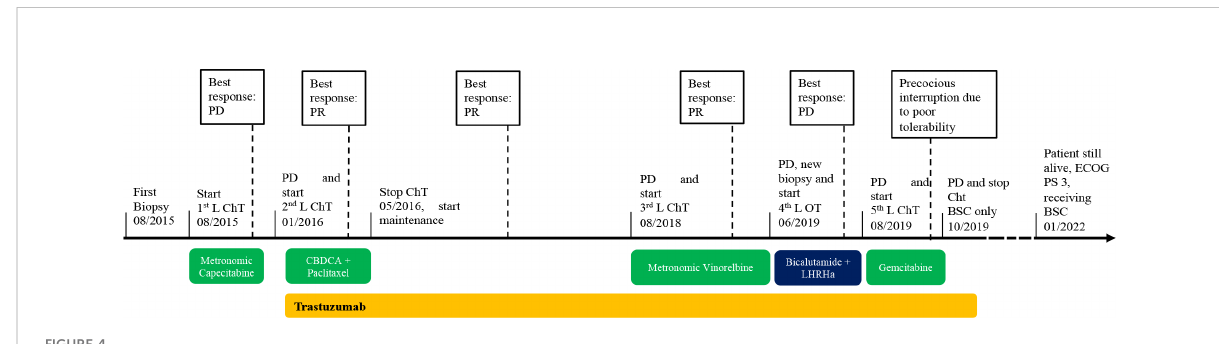
FIGURE 4 Timeline of systemic treatments administrated during patient ’ s disease history. BSC, best supportive care; CBDCA, carboplatin; ChT, chemotherapy; ECOG PS, Eastern Cooperative Group Perfomance Status; LHRHa, LHRH analogue; OT, hormonal therapy; PD, progression disease; PR, partial disease